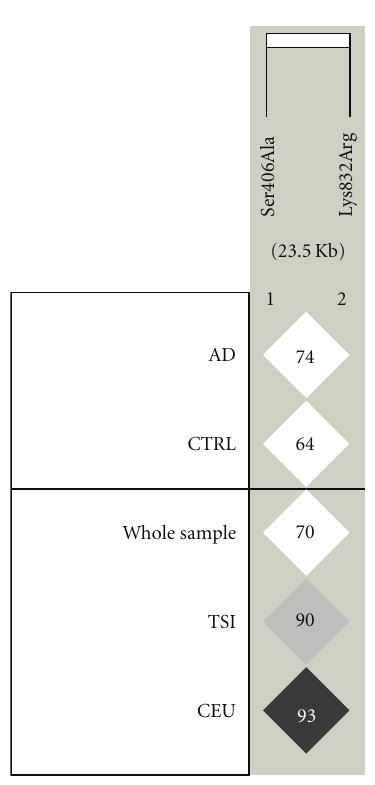
Figure 2: Pairwise LDs are shown, calculated between the ATP7B gene SNPs in AD, controls, whole sample and in HapMap European origin populations (CEU: Utah residents with Northern and Western European ancestry from the CEPH collection; TSI: Tuscans in Italy). The top panel depicts the location of the SNPs in the AT7PB gene. The intensity of the box shading is proportional to the strength of the LD (D (cid:3) confidence bounds) for the marker pair, which is also indicated as a percentage within each